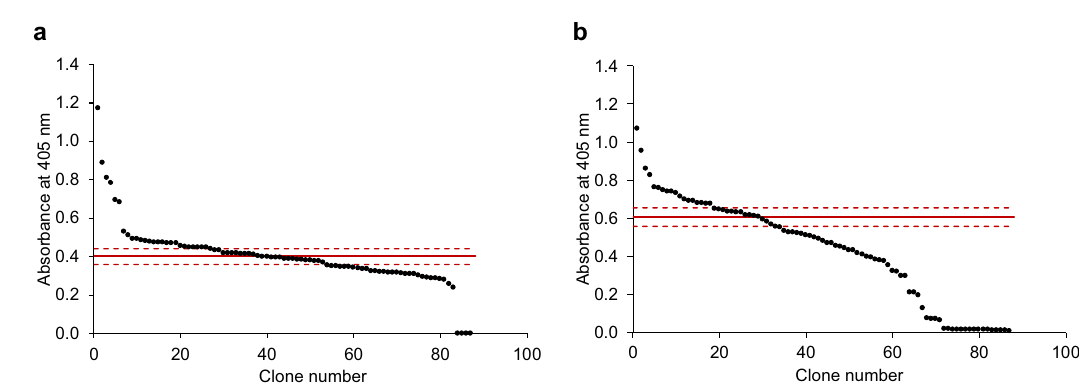
Figure 2. The OsmY-Tfu0937 activity in the spent medium of epPCR generated OsmY mutagenesis libraries was measured in a 96-well microplate. The activity was measured with the pNPG assay using an absorbance at 405 nm. The libraries were generated using ( a ) a low and ( b ) a high mutagenic rates. The activities of parental clones in column 6 were measured in the same 96-well microplate. The average of parental clones is shown as a solid red line and one standard deviation above and below the average are shown as dash red